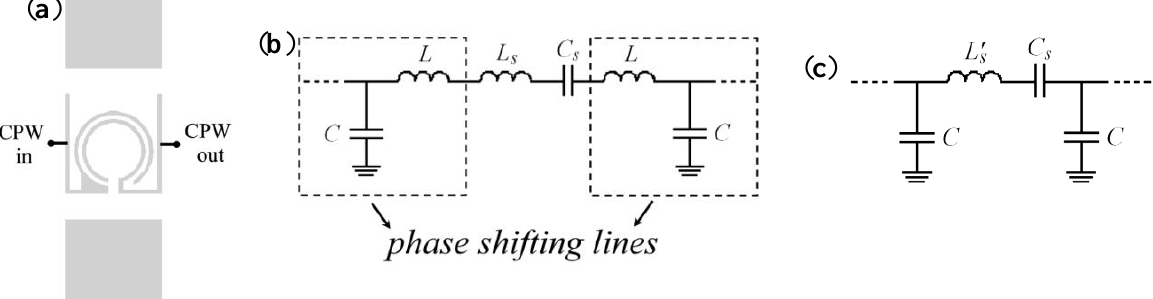
Figure 13. Layout ( a ), circuit model ( b ) and simplified circuit model ( c ) of a CPW